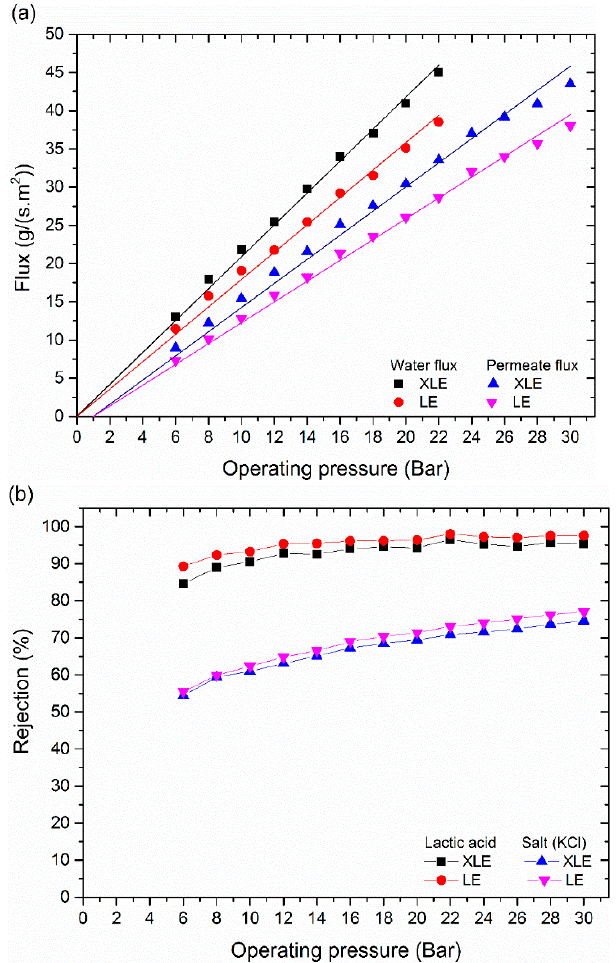
Figure 5. Results of experiments with Filmtec low energy membranes and a feed solution of 2.5 g of KCl and 650 ± 50 mg lactic acid per litre, pH of 3.5, conductivity of 4.8 mS/cm, and operating temperature of 25 °C: ( a ) pure water and permeate flux, and ( b ) lactic acid and KCl rejection. The rejection of lactic acid was always higher than the salt present in the feed